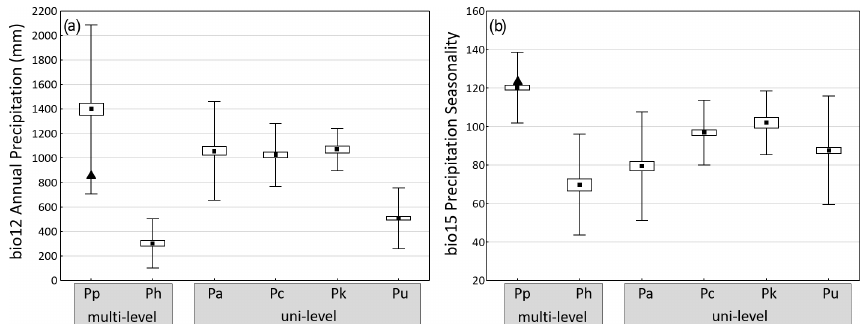
Figure 5. Average annual precipitation (a) and coefficient of variance of monthly precipitation (seasonality) (b) at occurrence sites of the six baboon species (means ± SE ± SD). Triangles indicate respective values at Simenti (data from WorldClim, variables bio12 annual precipitation and bio15 seasonality of precipitation). Baboon species (number of occurrence sites): multi-level social organization Pp – P. papio (177), Ph – P. hamadryas (64), uni-level social organization Pa – P. anubis (120), Pc – P. cynocephalus (96), Pk – P. kindae (32), Pu – P. ursinus (244).